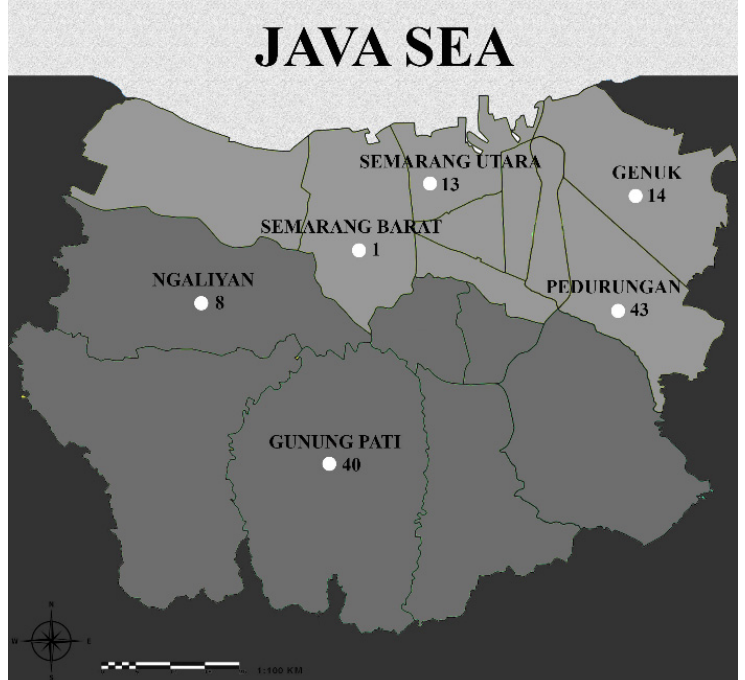
Figure 1. The distribution of study area and subjects in Semarang, the capital city of Central Java Indonesia; lowland (0.75–3.5 m below sea level; dark grey color) and highland (90–359 m above the sea level; light grey color), sea (white color). The subjects were 70 from lowland areas; Semarang Utara (13), Semarang Barat (1) Genuk (14), and Pedurungan (43), and 48 from highland areas; Ngaliyan (8) and Gunung Pati (40). Table 2. Newborn characteristics of the study